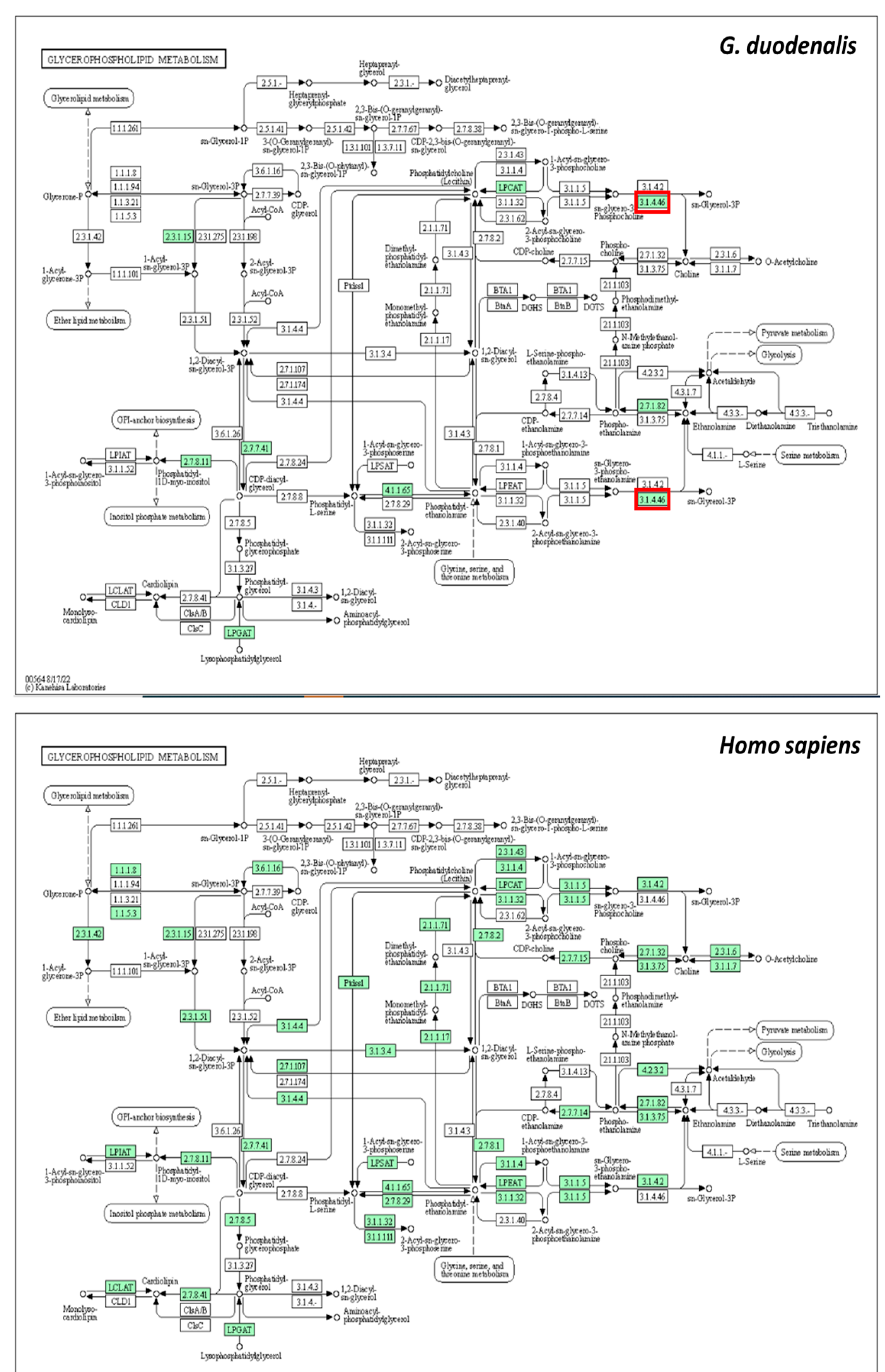
Figure 8. Glycerophospholipid metabolism of G. duodenalis and Homo sapiens . Green boxes represent proteins that play a role in each organism. Red squares represent proteins that play a role only in G. duodenalis.